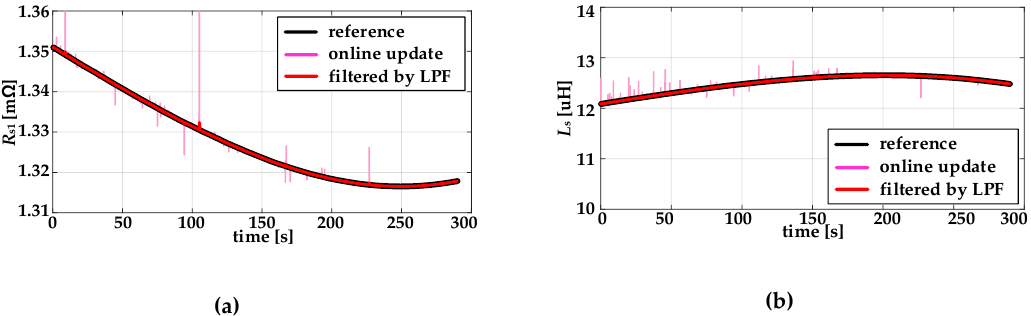
Table 1. Specification of battery pack.